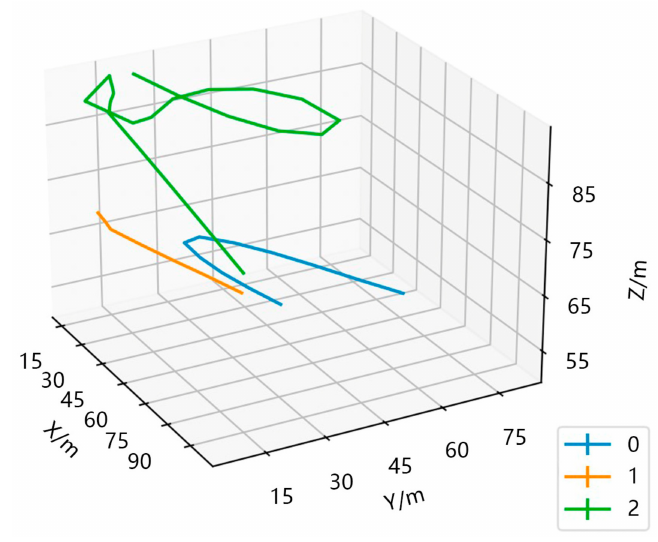
Figure 5. A set of flight trajectories in our simulation experiment.